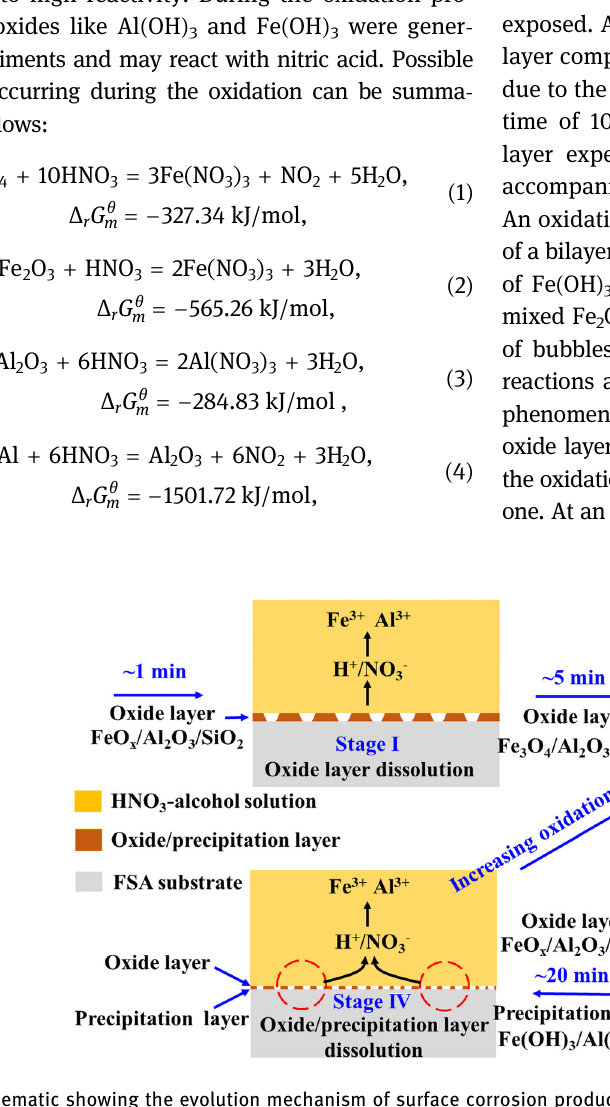
Figure 3: Schematic showing the evolution mechanism of surface corrosion products of FSA powders oxidized with 20 wt% HNO 3